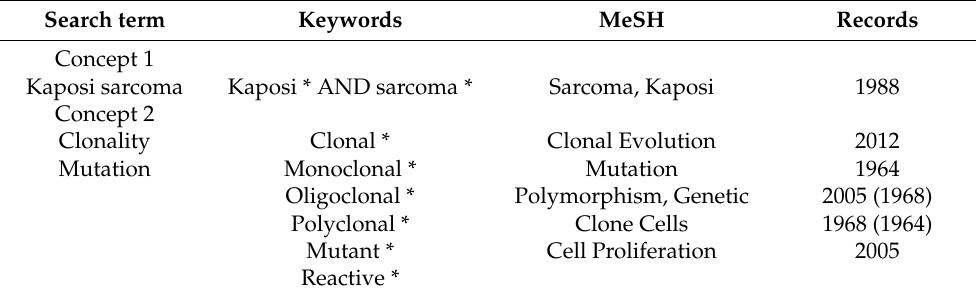
Table 1. Search terms and strategies in MEDLINE and Web of